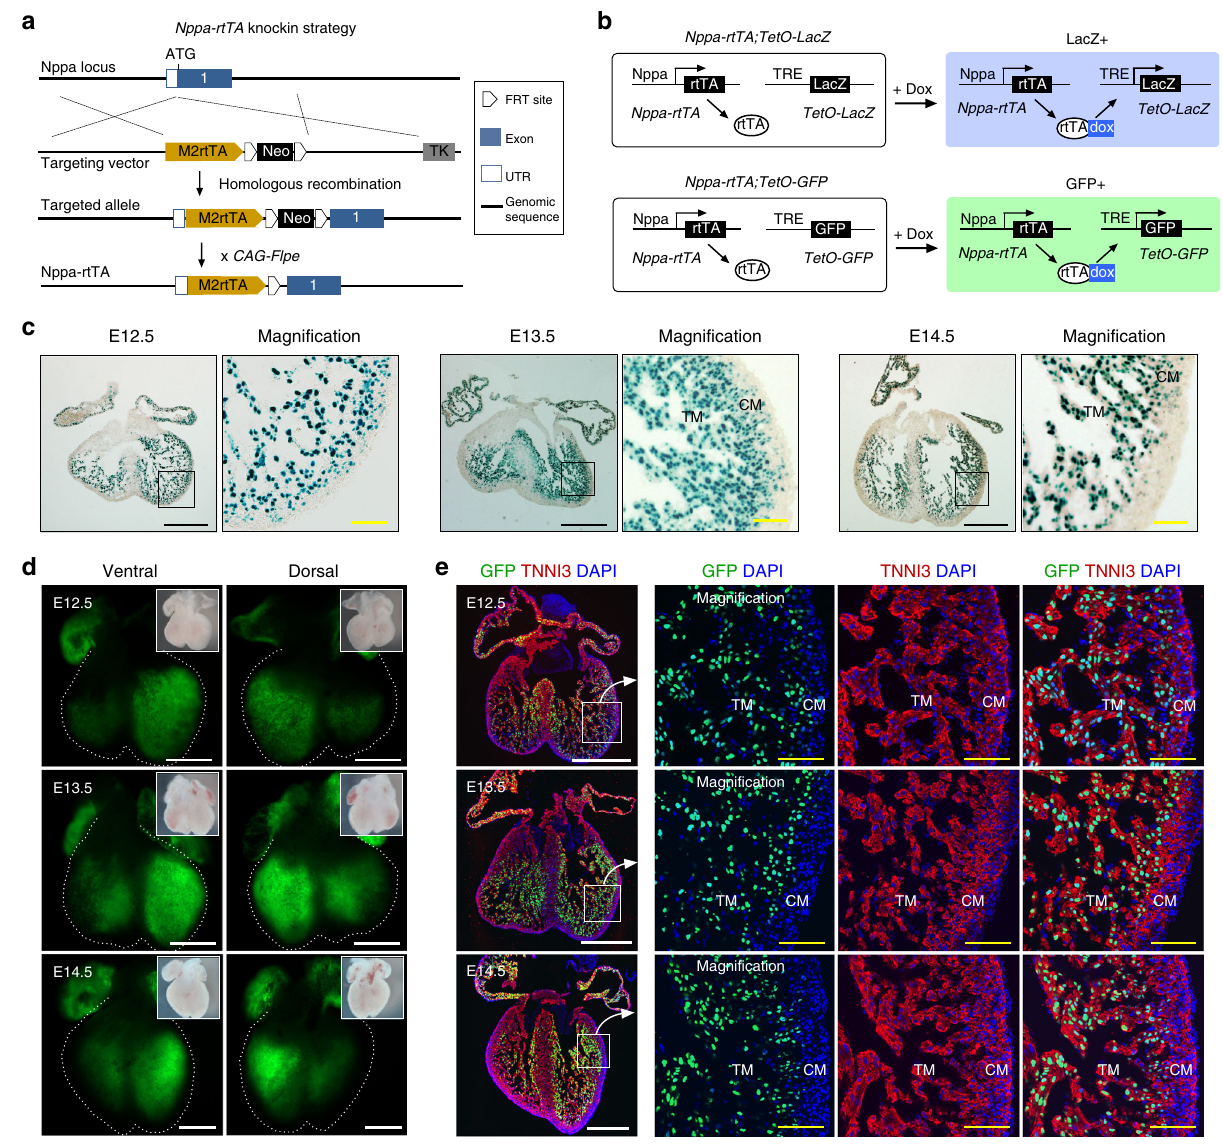
Fig. 2 Generation and characterization of Nppa-rtTA mouse line. a Schematic showing knock-in strategy of Nppa-rtTA mouse line by homologous recombination. b Schematic showing characterization of Nppa-rtTA by rtTA responding reporter mice TetO-LacZ or TetO-GFP . LacZ or GFP is expressed after doxycycline treatment (+Dox). c X-gal staining of E12.5 to E14.5 Nppa-rtTA;TetO-LacZ heart sections. d Whole-mount fl uorescence view of Nppa-rtTA; TetO-GFP mouse hearts. Inserts are bright- fi eld images of same hearts. Dotted lines indicate epicardium. e Immunostaining for GFP and TNNI3 on Nppa-rtTA; TetO-GFP heart sections showed GFP is highly enriched in trabecular myocardium (TM) but sparse in compact myocardium (CM). Each image is a representative of four individual samples. Scale bars, 500 µ m ( white or black ); 100 µ m ( yellow